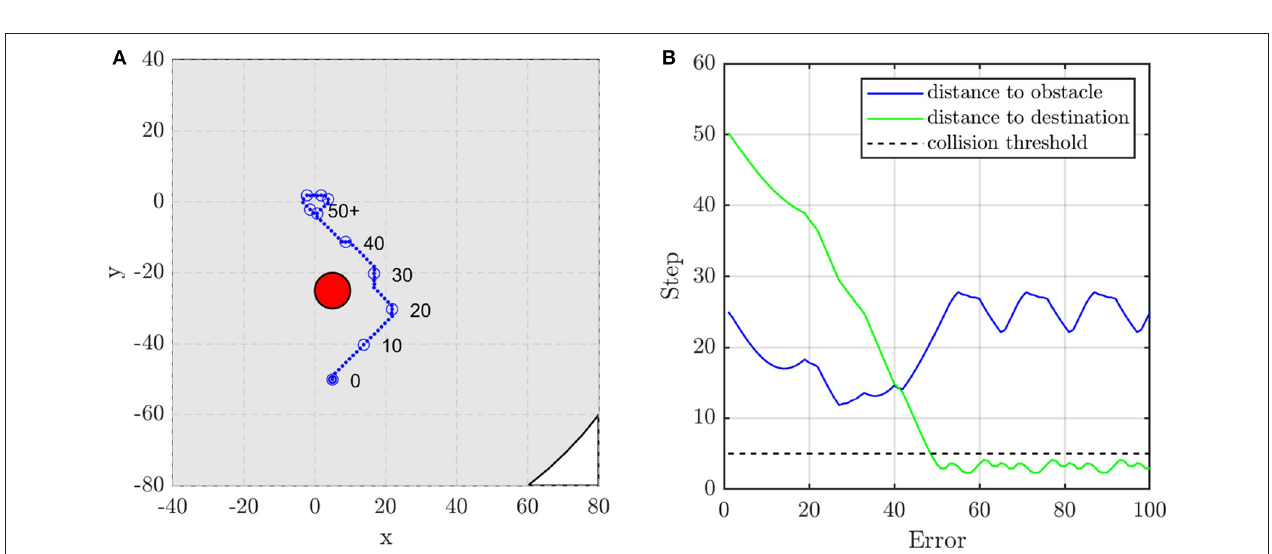
FIGURE 10 | The agent’s (A) trajectory and (B) distance to obstacle and destination when the obstacle is on the line between the agent’s initial and target position. The red circle is the obstacle with the radius of d safe and the blue dots are the trace of the agent. (22), the left time (equivalent to left steps) for all the obstacles is shown in Figure 12B . In a similar way, according to equation (18), the maximum state-action value Q for the obstacle is shown in Figure 12C